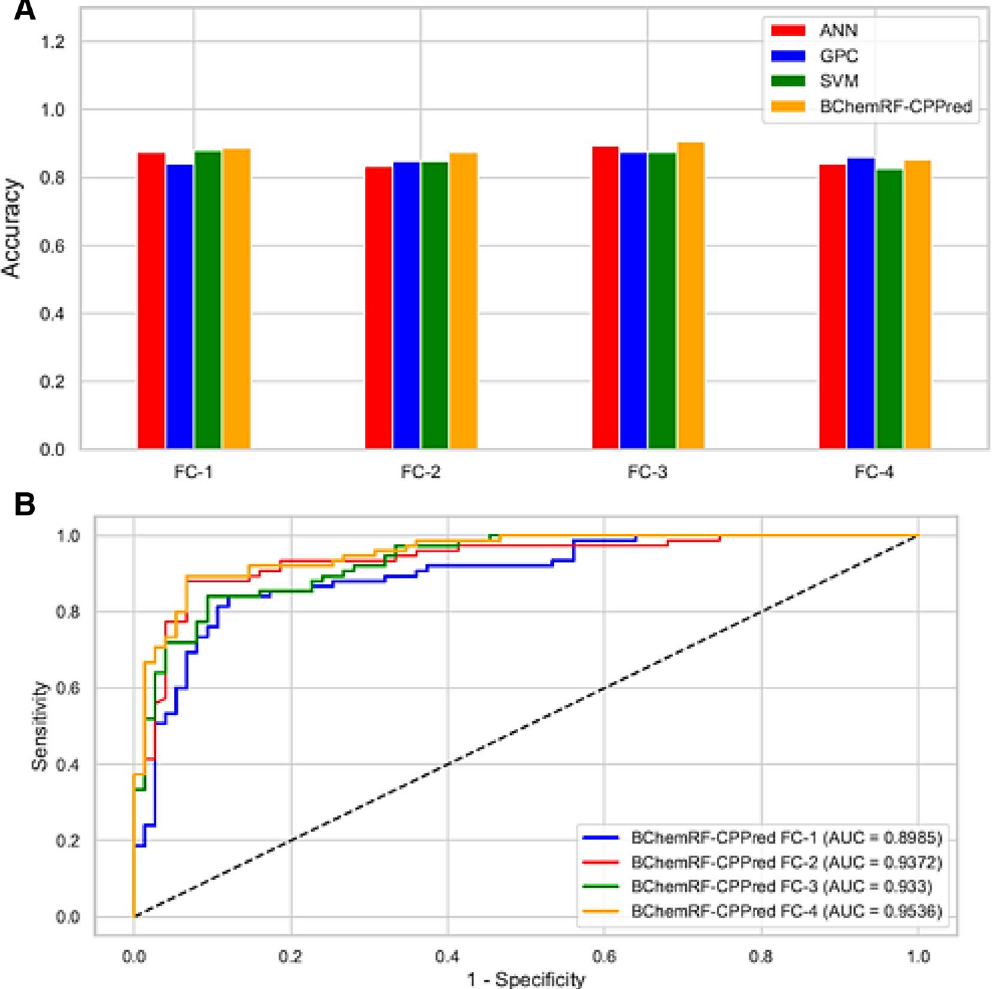
Figure 2. ( A ) Accuracy of ANN (red), GPC (blue), SVM (green), and BChemRF-CPPred (orange) by FCs evaluated in the independent test. ( B ) ROC curves and AUC of ML-based frameworks using the FC-1, FC-2, FC-3, and FC-4 in the independent test.